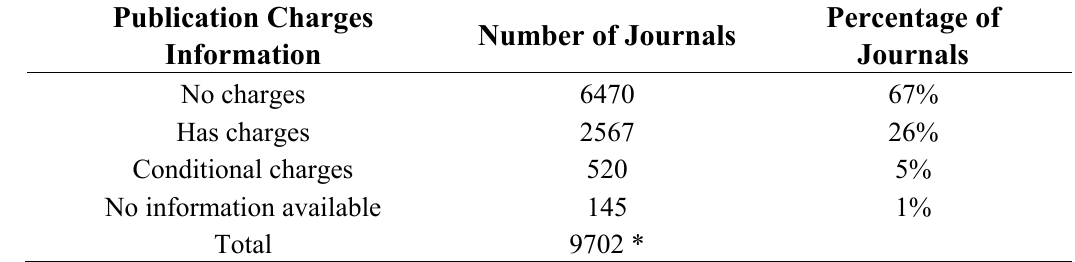
Table 1. Directory of Open Access Journals (DOAJ) journals and publication charges May